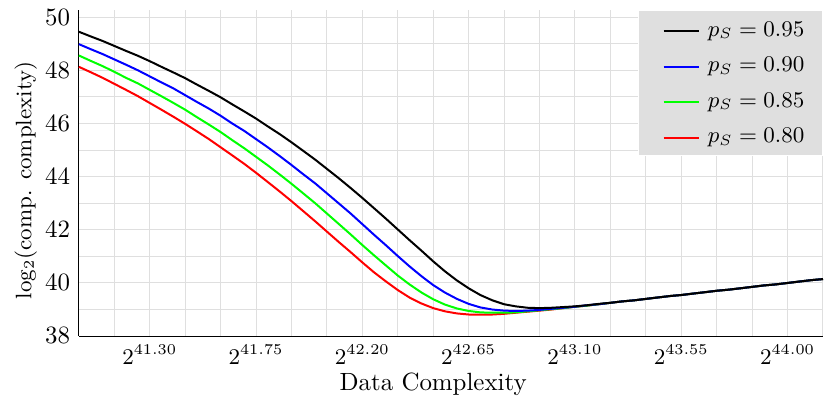
Figure 5: Theoretical Complexity for Algorithm 2MC on